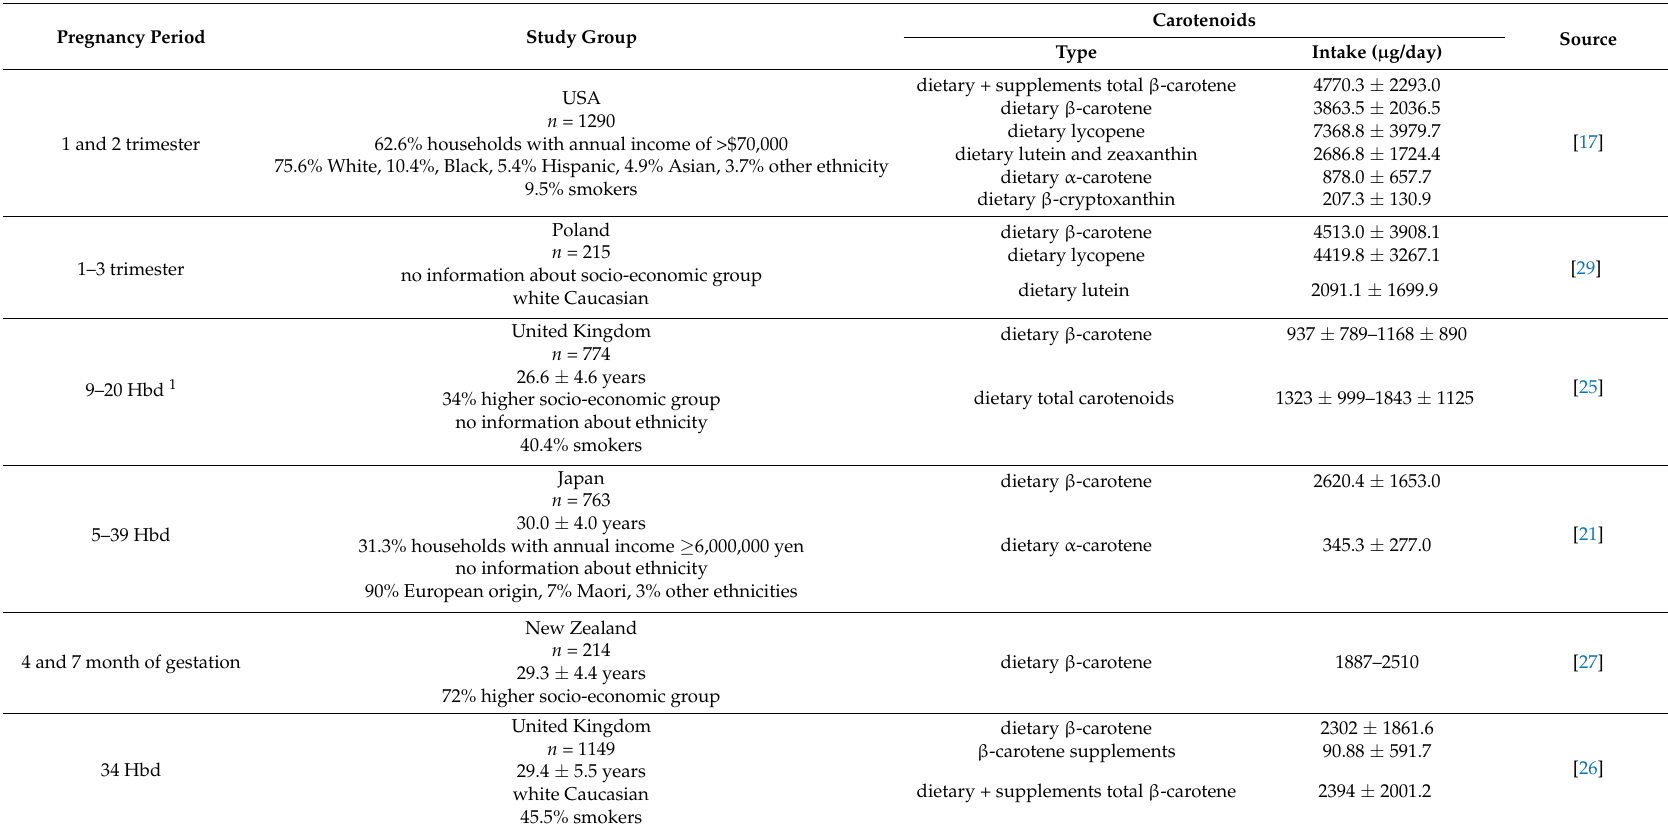
Table 1. Mean intake of carotenoids intake during